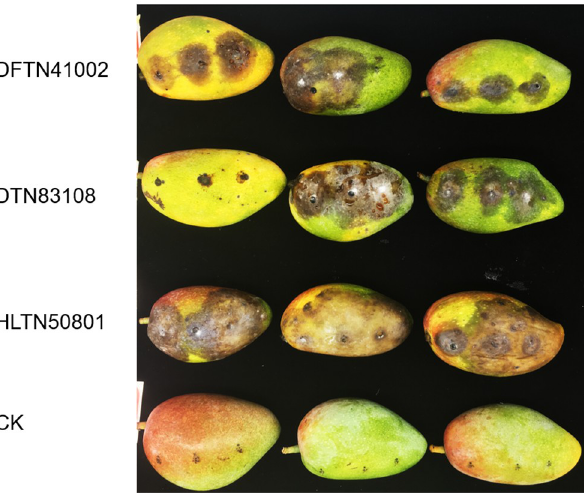
Fig 1. The virulence of Lasiodiplodia theobromae isolates at 5 d after inoculation.